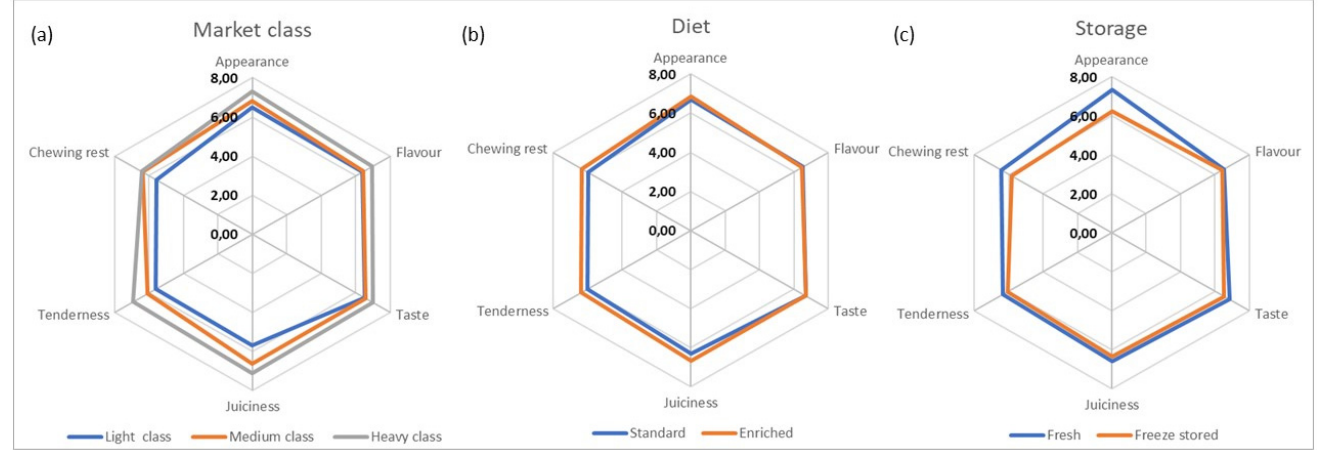
Figure 3. Sensory analysis of control and functional breast fillets from light, medium and heavy broilers at 24 h post-mortem and after freeze storage for 30 days (cooked state). For every market class ( a ), data are reported in terms of mean ± standard deviation of n = 28 tastings of breast meat from broilers receiving standard ( n = 14) and experimental ( n = 14) feeding, both at 24 h post-mortem ( n = 14) and following freeze storage ( n = 14). For the dietary treatment ( b ), data are expressed as mean ± standard deviation of n = 42 tastings of meat from light ( n = 14), medium ( n = 14) and heavy ( n = 14) broilers, both in fresh status ( n = 21) and after freeze storage ( n = 21). For fresh or freeze stored samples ( c ), data are expressed as mean ± standard deviation of n = 42 tastings of meat from light ( n = 14), medium ( n = 14), and heavy ( n = 14) broilers receiving both standard ( n = 21) and functional ( n = 21) feed.